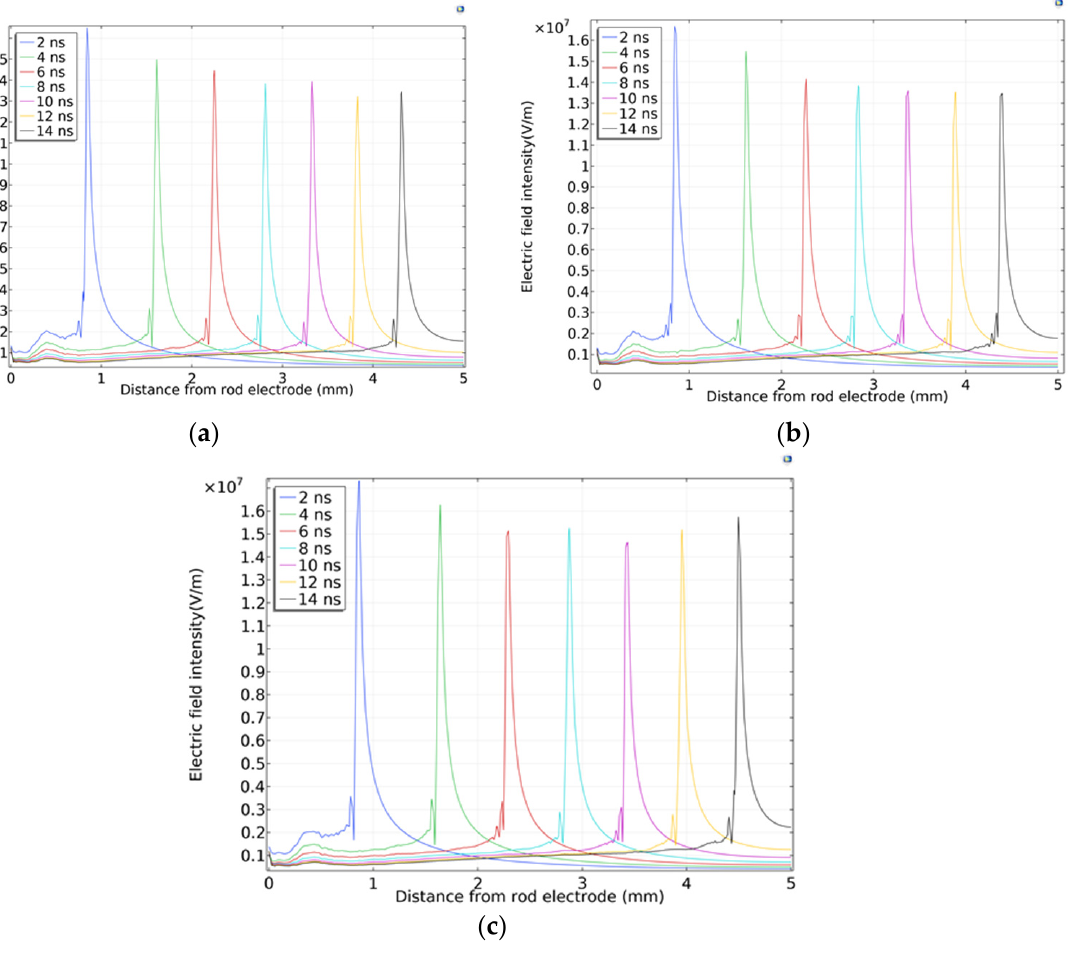
Figure 4. One-dimensional distribution of electric field intensity along the axis: ( a ) Dry clean air, ( b ) 40% relative humidity, ( c ) 80% relative humidity